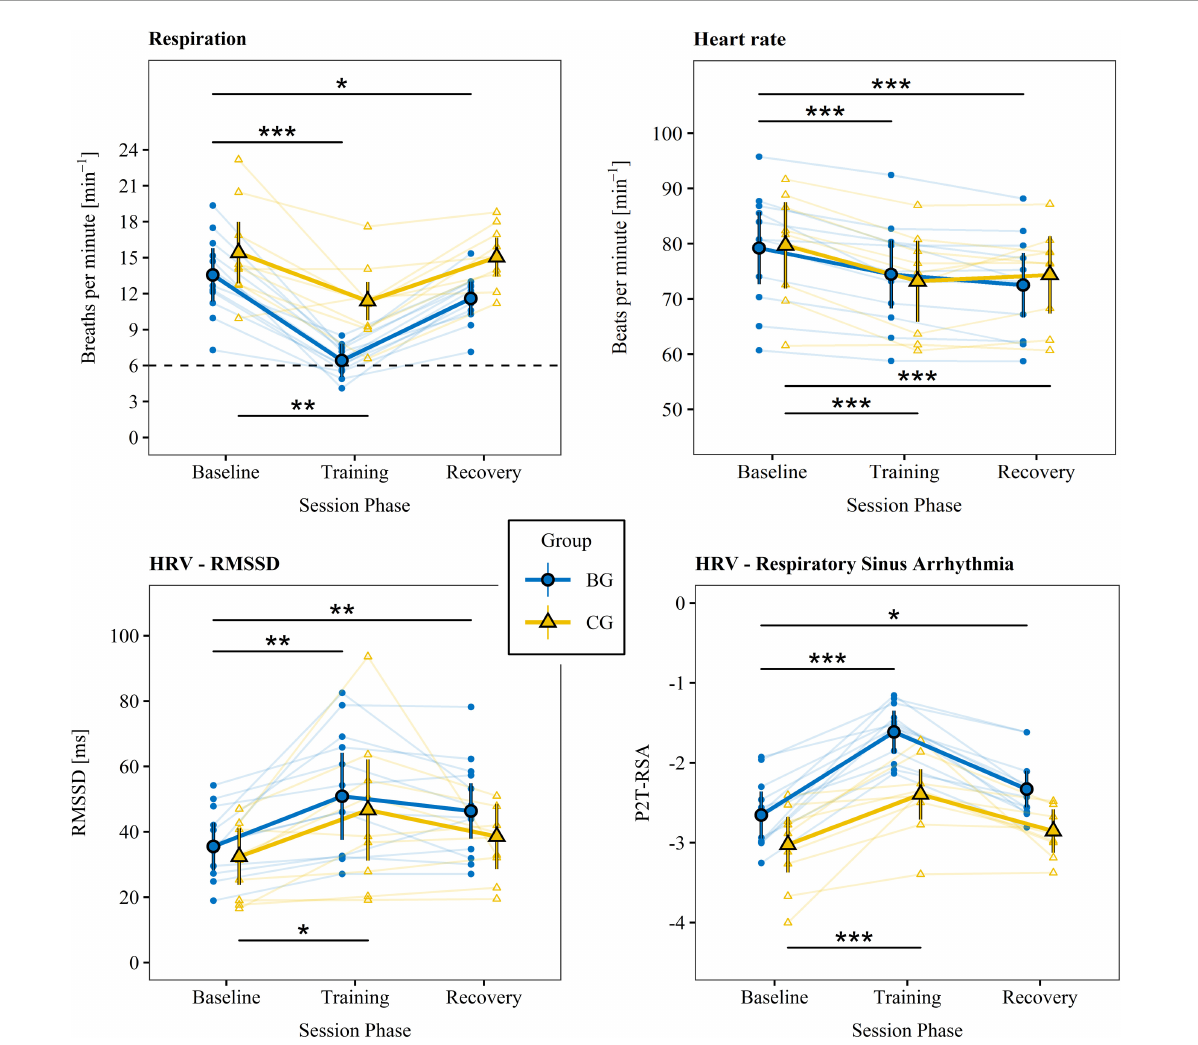
FIGURE3 Physiological measures. Physiological parameters were recorded directly before (baseline), during (training), and 5 min after (recovery) each training session. The small data points represent means of individual participants summarized over training sessions. The large data points reflect estimated marginal means summarized across participants and sessions that account for random subject effects and individual differences in the new Body Mass Index. Vertical lines indicate 95% CIs. The dashed line stands for the target breathing rate during training. Phases were compared between baseline and training as well as baseline and recovery for the BG (top lines) and CG (bottom lines), respectively. HRV, heart rate variability; RMSSD, root mean square of successive differences; BG, biofeedback group; CG, active control group; P2T-RSA, natural logarithm of the respiratory sinus arrhythmia calculated by the peak-to-trough method. *** p < 0.001. ** p < 0.01. * p <